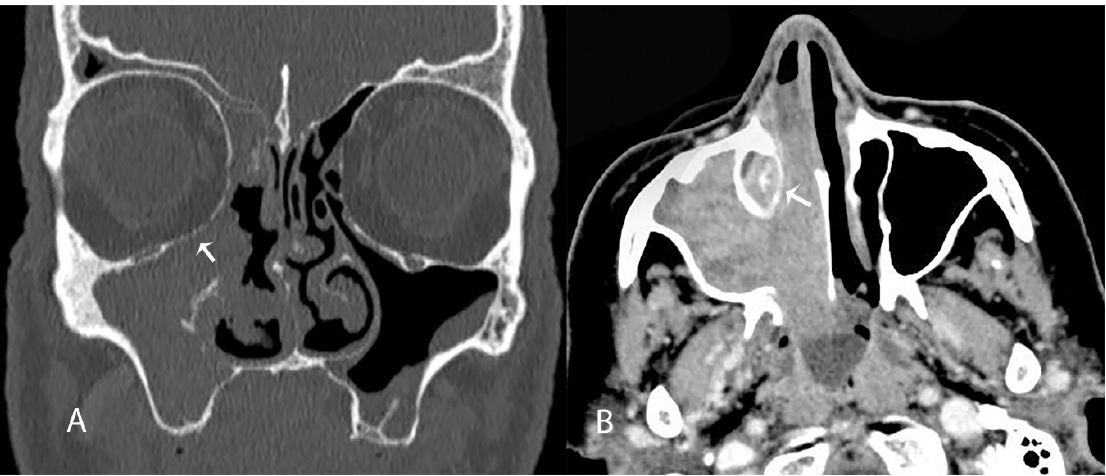
Figure 4. Carcinoma of the maxillary sinus and the lateral nasal cavity wall. Erosions of the lower orbital wall—arrow, frontal plane ( A ); apparent invasion of the nasolacrimal duct—arrow, axial plane ( B ).